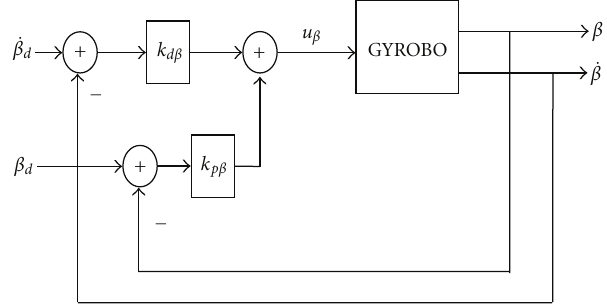
Figure 3: Lean angle control for balancing.